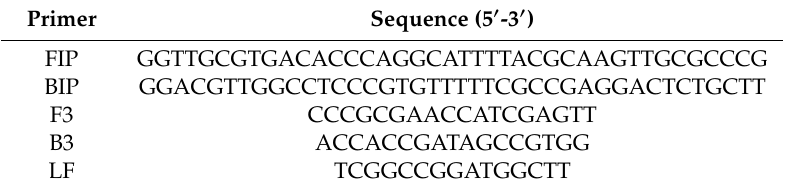
Table 1. LAMP primers from the Internal Transcribed Spacer (ITS) of Manihot esculenta